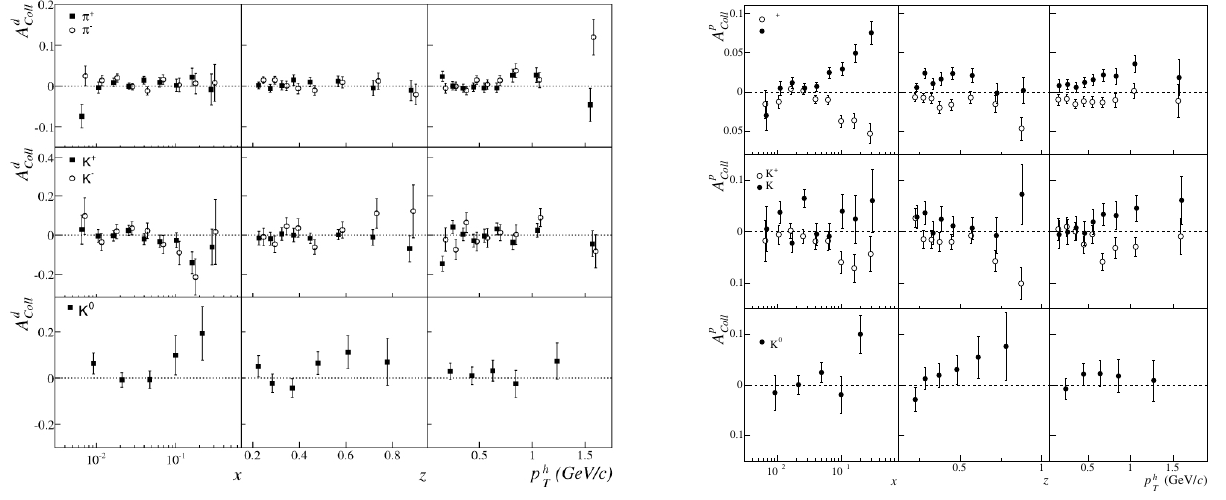
Figure 3. COMPASS measurements of the Collins asymmetries for π ± and K ± , 0 on deuterons (left) and protons(right).